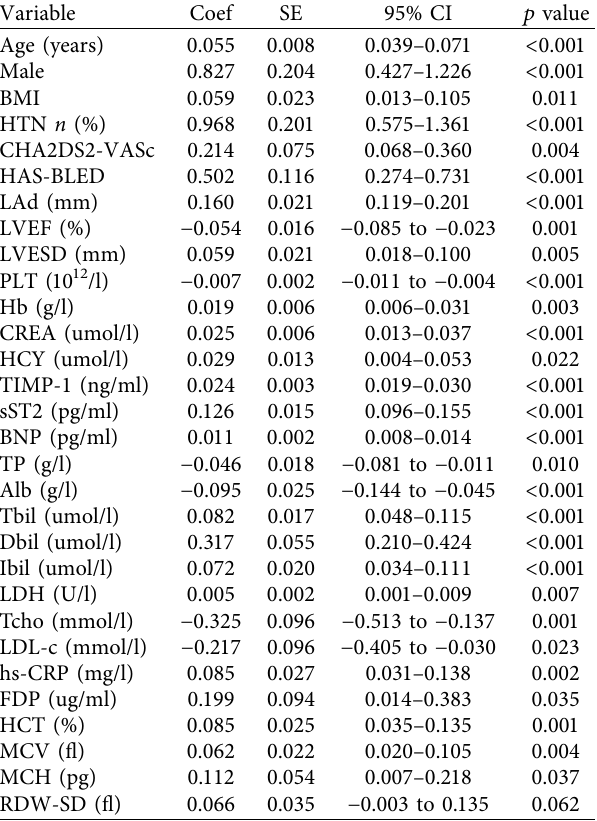
Table 3: Univariate ordinal logistic regression analysis of the factors with sinus rhythm and paroxysmal, persistent AF.